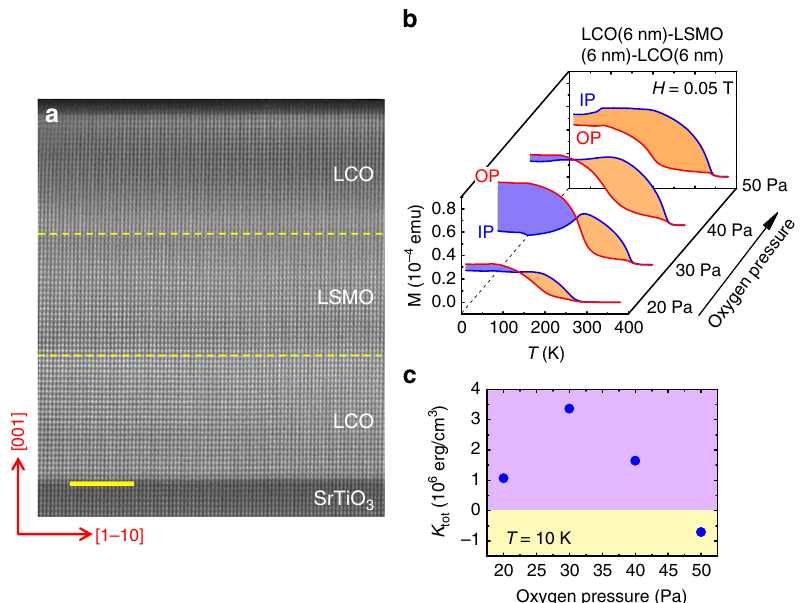
Fig. 5 Effects of oxygen pressure on LCO/LSMO/LCO trilayers. a A high-angle annular dark- fi eld (HAADF) image of the cross section of the LCO(6 nm)/ LSMO(6nm)/LCO(6 nm) trilayers fabricated under an oxygen pressure of 50 Pa, showing a P/P type interface as marked by yellow dashed lines. Scale bar, 5 nm. b Thermomagnetic curves for the LCO/LSMO/LCO trilayers prepared under different P and an out-of-plane (OP) applied fi eld of 0.05 T, respectively. In-plane magnetic anisotropy is observed under the P a nominal one. The actual thickness is slightly thicker than the nominal one according to the HAADF image. c Magnetic anisotropy energy as a function of